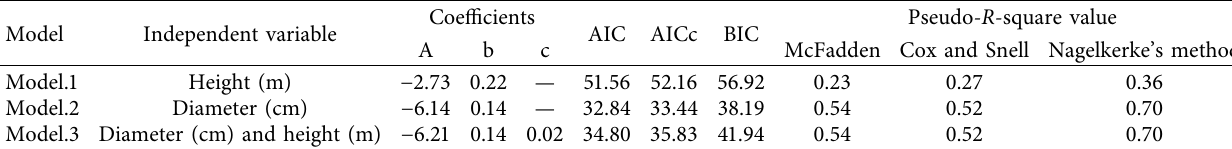
Table 2: Coefficients, selection parameters, and results for the logistic regression.